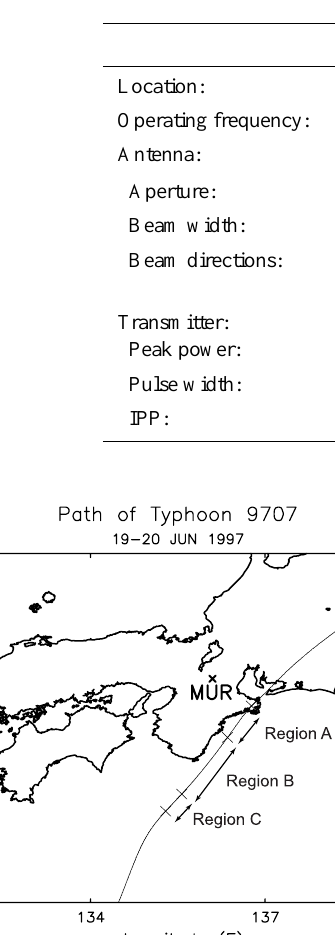
Table 1. Specifications of the MU radar, the L-band BLR, and the C-band radar